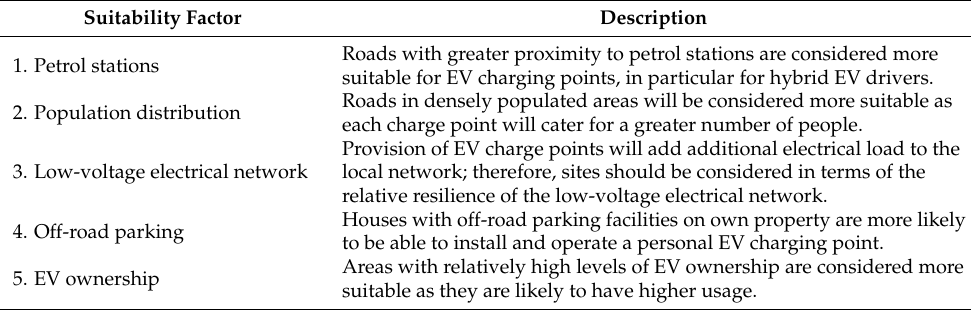
Figure 5. Remaining suitable road segments following car park buffer zone mapping. Table 3. Table of suitability factor criteria.